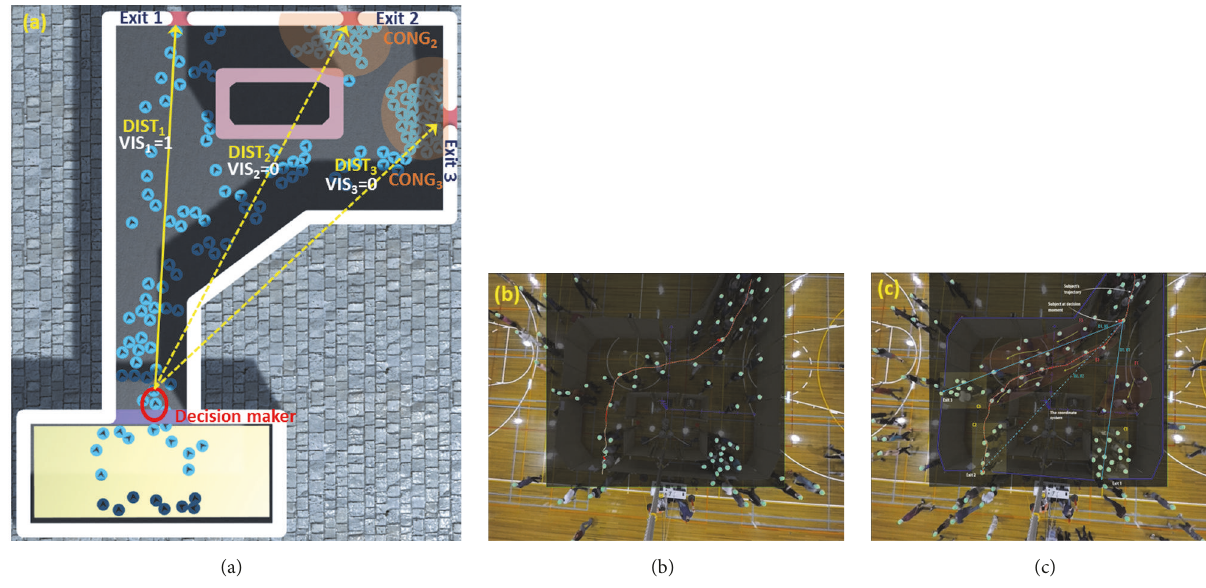
Figure 6: Visual illustration of the exit attributes during the simulation process (image (a)) and during the data extraction process (image (c)). The choice of exit is modelled based on five variables obtained from four different attributes. These attributes include spatial distance (DIST), congestion level (CONG), flow sizes (FLOW), and visibility (VIS) associated with each alternative exit.